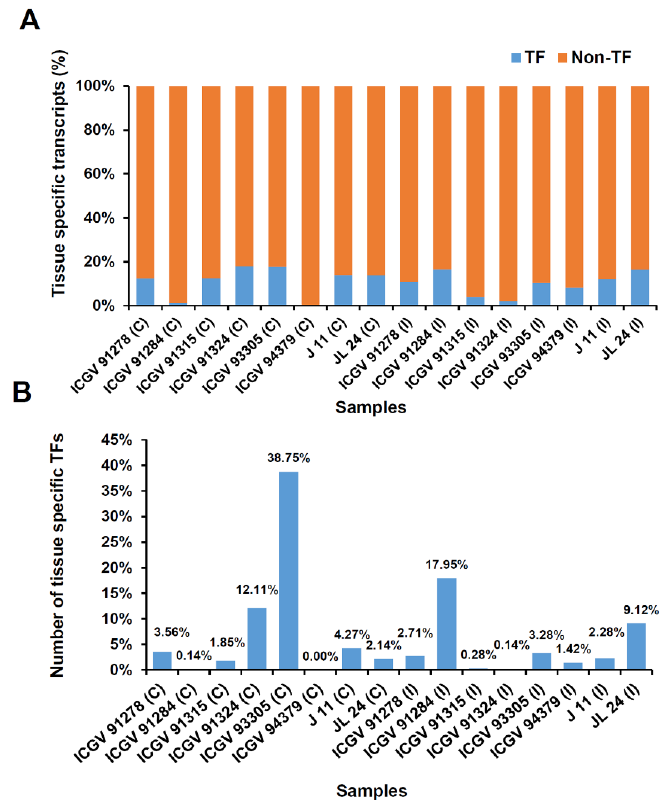
Figure 6. Spatial transcript expression identified in 16 samples. The figure shows the number of sample or genotype specific transcript in all 16 samples. Tissue specificity index (τ) was calculated to identify the genotype specific transcript. In the present study, transcripts with τ ≥ 0.9 were considered as sample specific. ( A ) Blue color represents sample specific transcript encoding transcription factors (TF) and orange color represents Non-TF transcripts. ( B ) The figure shows the distribution of sample specific transcript encoding transcription factors in all 16 samples.